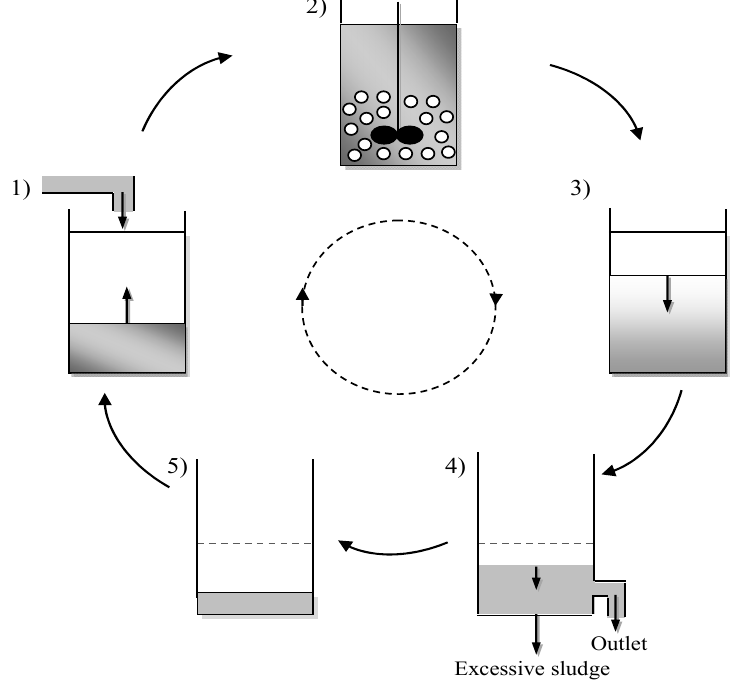
Figure 1. Phases of the SBR operating cycle: 1) filling 2) biological reactions (aerobic, anaerobic) 3) sedimentation 4) decantation 5) idle state.